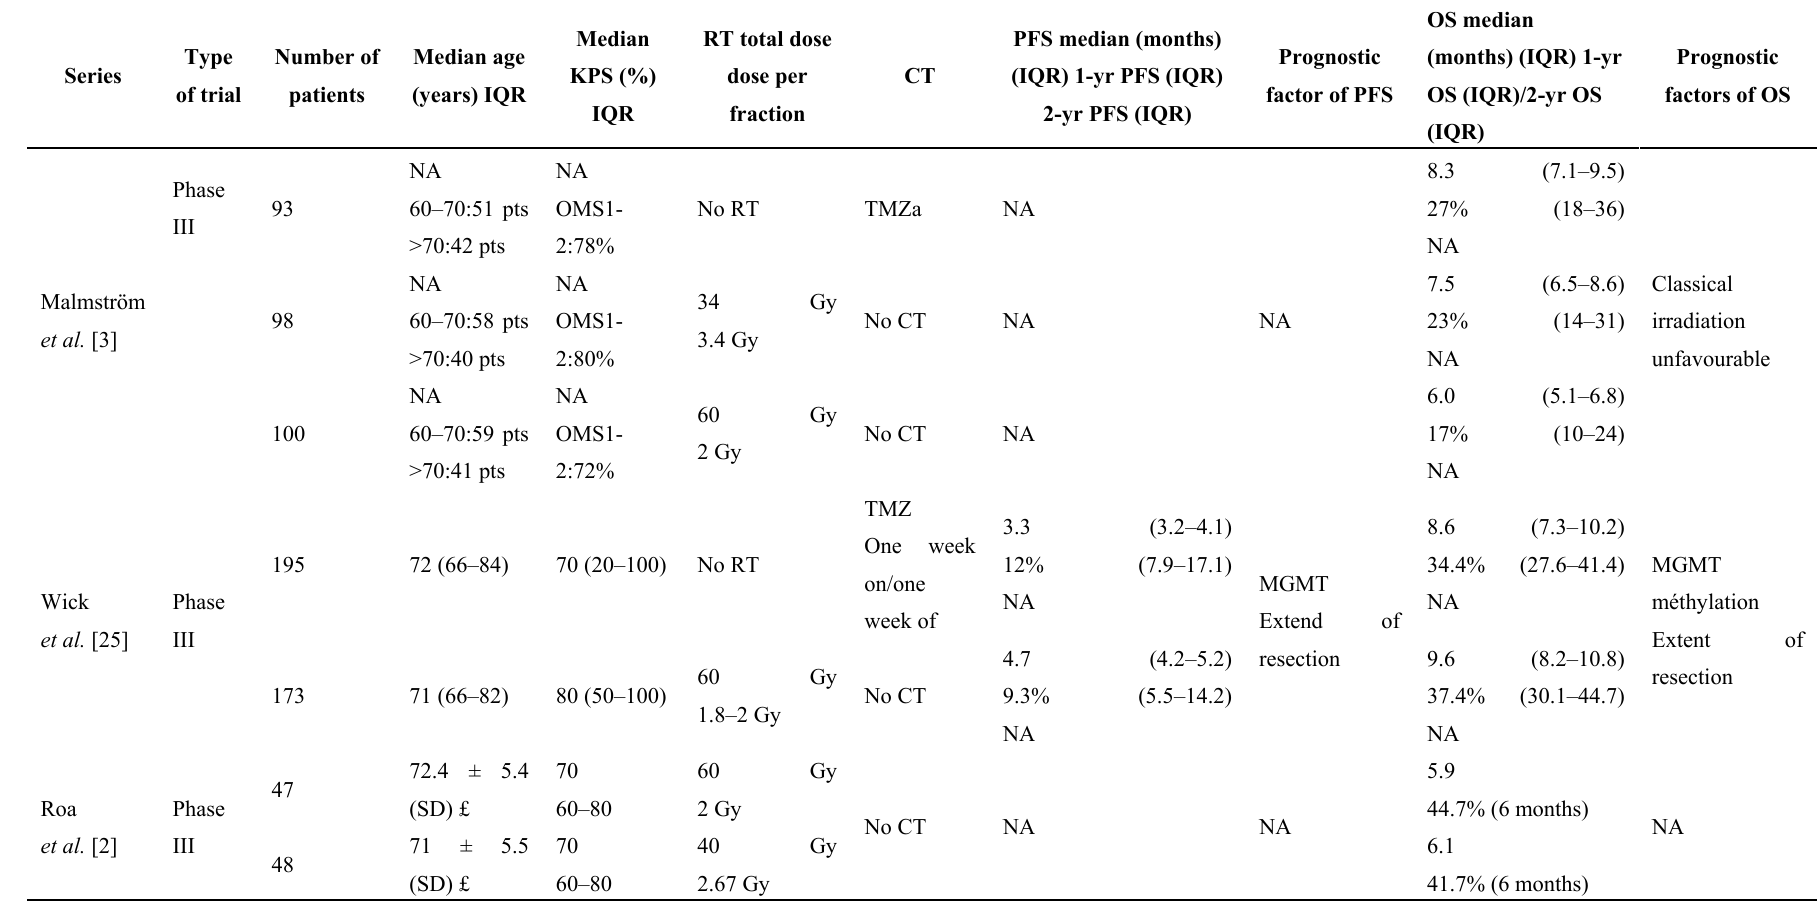
Table 2. Results of the literature of elder patients with glioblastoma treated at least with